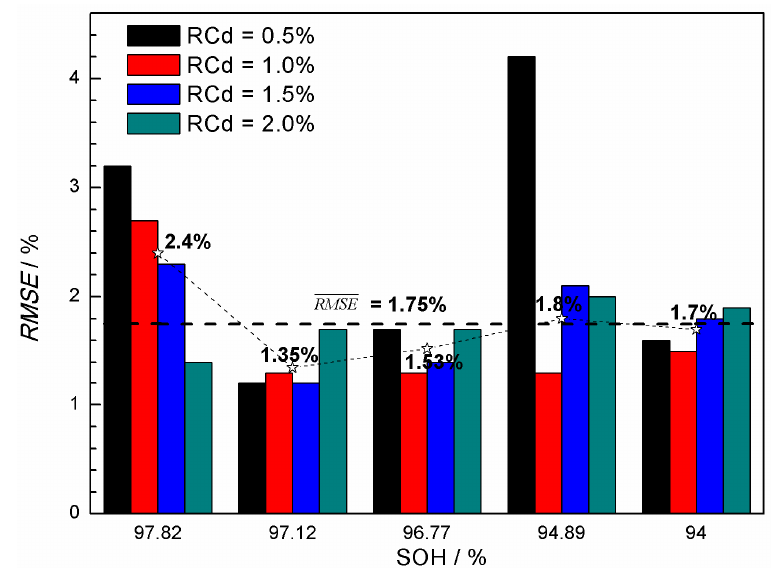
Figure 5. Prediction root-mean-square error ( RMSE ) for a Ni-MH battery in the charge-discharge test at 1.0C using ( C discharge , ∆ V charge ) data groups at different SOH with various RCds.